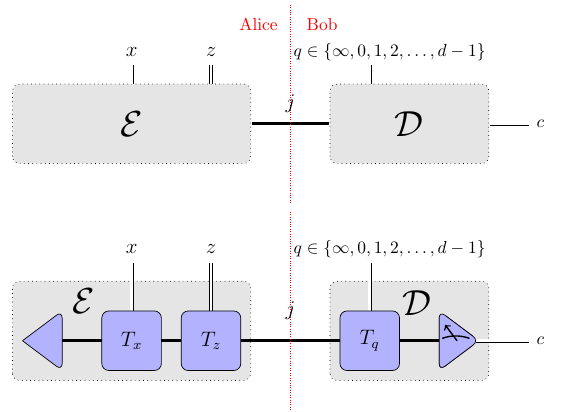
FIG. 11. The Torpedo Game in a prepare-and-measure (top) versus transformational scenario (bottom). The empirical models e x , z , q in either scenario are the same both quantumly and clas- sically. Hence classical and quantum strategies for any ( 2, 1 ) d information retrieval task can be equivalently expressed in prepare-and-measure or transformational